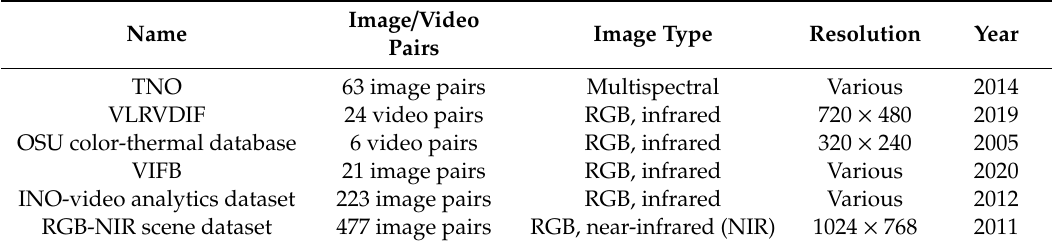
Table 6. Details of existing infrared and visible image fusion